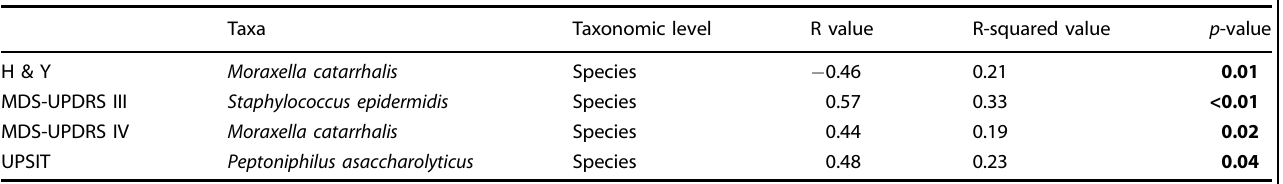
Table 1. Altered deep nasal microbial community features correlated with clinical variables of PD subjects.